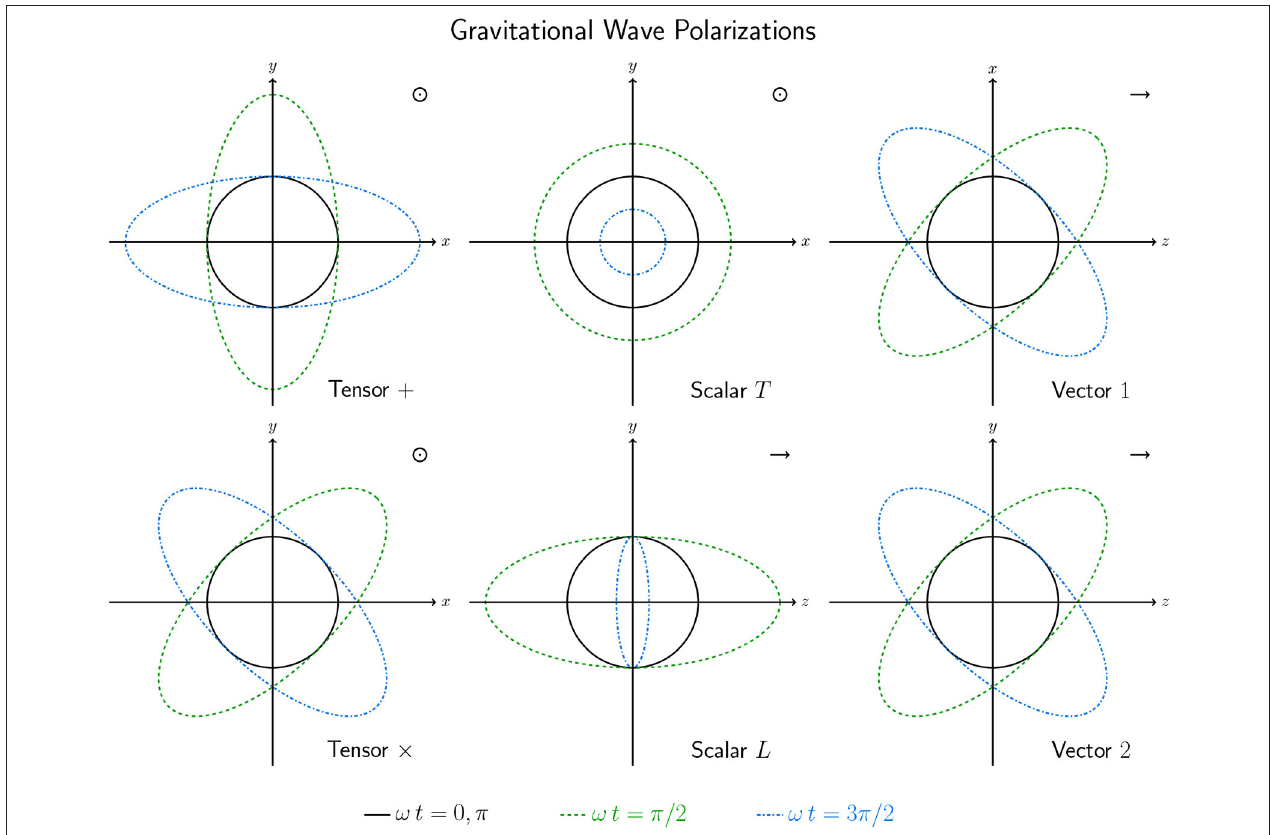
FIGURE 6 | Possible gravitational wave polarizations. A circle of test masses is distorted differently for each polarization propagating on the z -direction as a function of time ( ω t 0, π/ 2, π ,3 π/ 2). General Relativity only contains the two tensor polarizations = scalar mode (Scalar T ), a longitudinal scalar (Scalar L ) and two vector modes (Vector